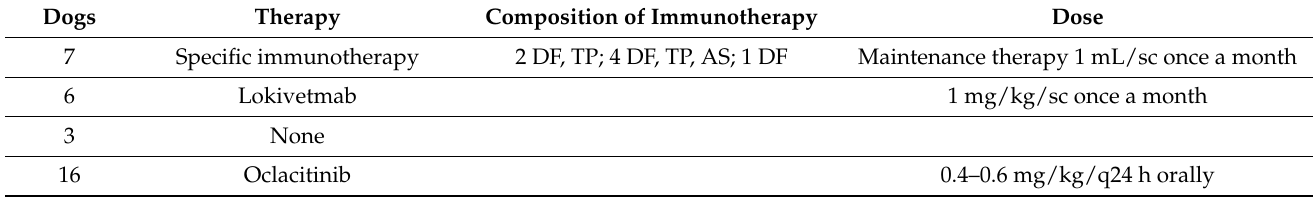
Table 3. Ongoing treatment at day 0 and at the end of the clinical